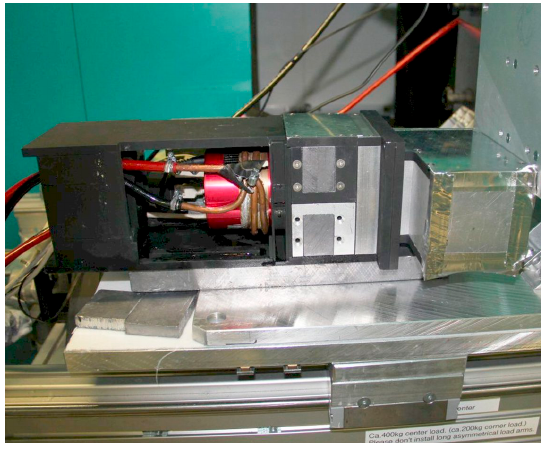
Figure 3. Design of the small camera box. A lead brick surrounds the lens to cut direct sight to the scintillation screen. The mirror box is exchangeable for different sizes.